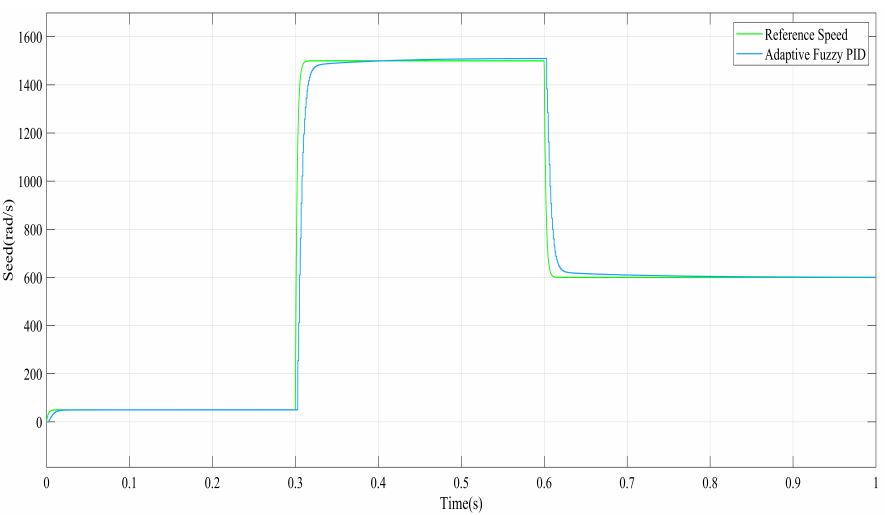
Figure 6. Adaptive fuzzy PID speed controller.